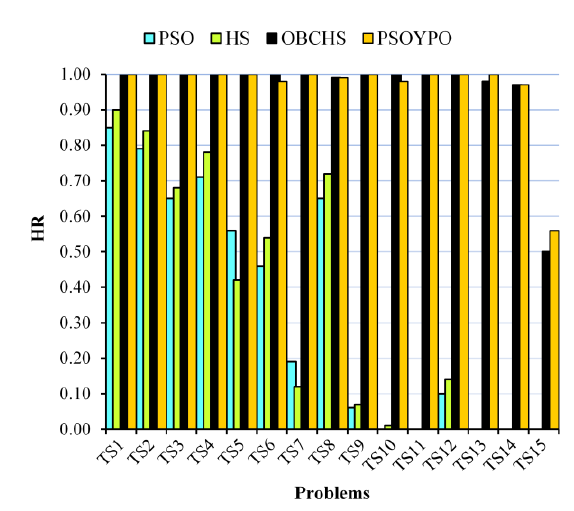
Figure 2. Robustness comparison between the PSO, HS, OBCHS, and PSOYPO